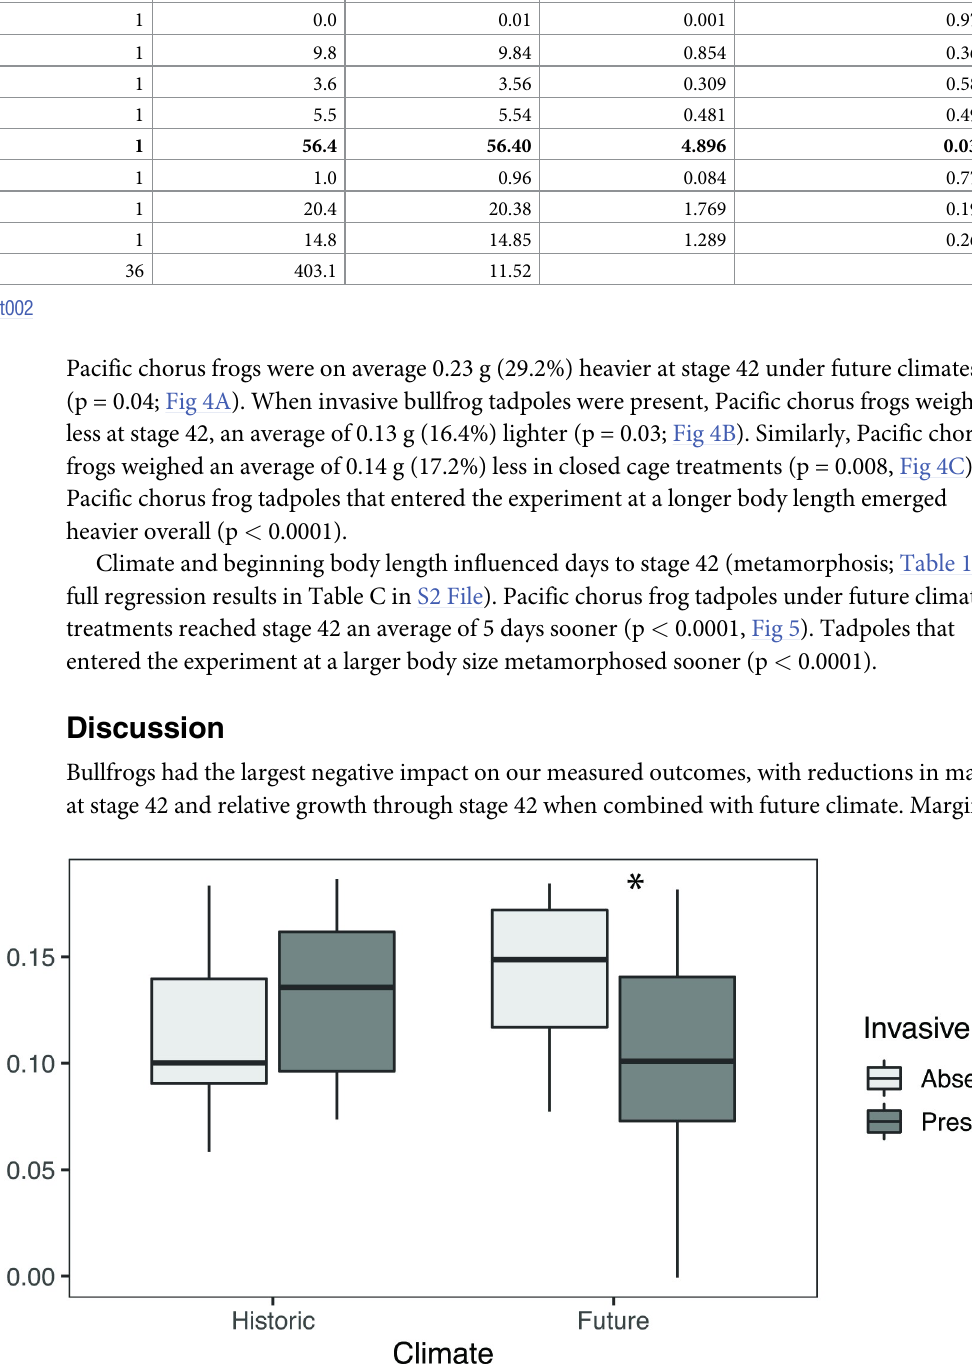
Fig 3. Bullfrog larvae reduced the absolute relative growth of Pacific chorus frog larvae under simulated future conditions. Relative growth represents the proportion of the initial body length (snout-vent length [SVL]) obtained during the experimental period. Under historic (cooler, less evaporation) conditions, no effect of bullfrogs was observed on growth of chorus frogs. Under future conditions, bullfrog presence reduced growth of chorus frog larvae (t-ratio = 2.254; df = 2,35; p = 0.0304; marked with an asterisk in plot). Boxplots are standard boxplots, with median and standard quartiles ± 1.5 � IQR whiskers.